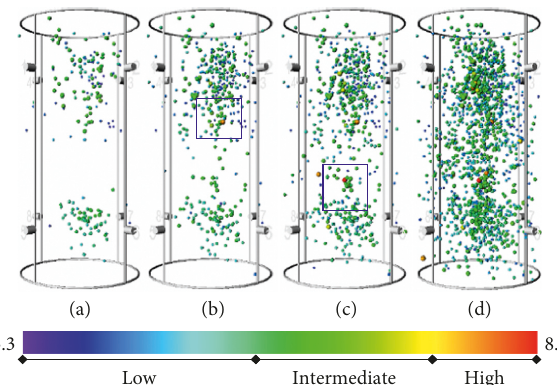
Figure 5: The spatial-temporal distribution of the AE events in Sim2. (a) 0–318s; (b) 0–324 s; (c) 0–328s; (d) 0–346